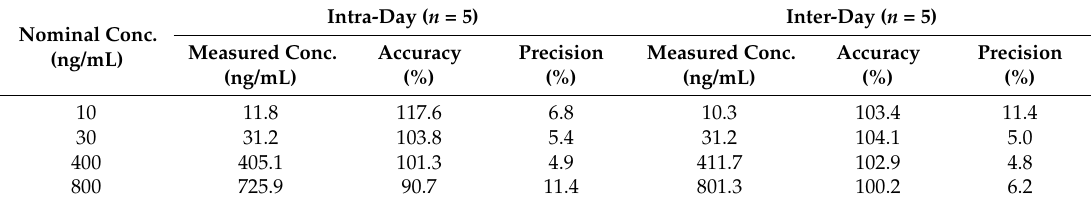
Table 1. Intra- and inter-day accuracy and precision for the determination of acetyl tributyl citrate (ATBC) in rat plasma.